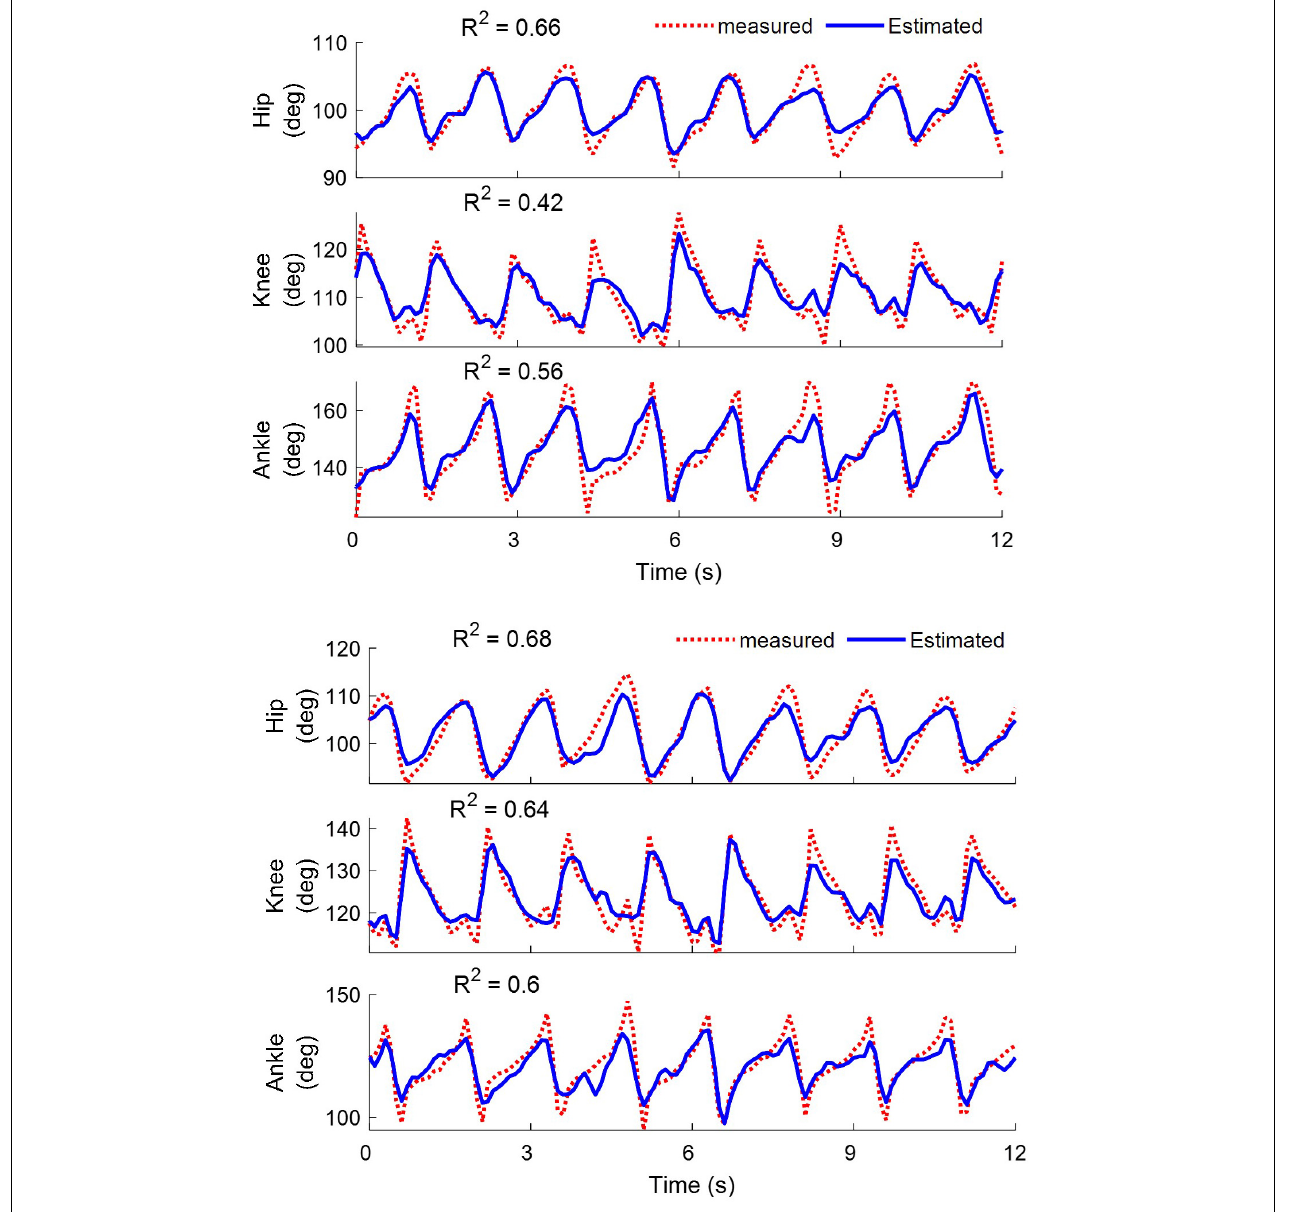
FIGURE 11 | Examples of decoding the hip, knee, and ankle joint angles for the left (top) and right leg (bottom) during walking on the treadmill. The results are obtained from cat 1 on day 12 after implantation. The coefficient of determination ( R 2 ) values obtained for the left leg are 0.66, 0.42, and 0.56 for the hip, knee and ankle angles, respectively. For the right leg, the R 2 values are 0.68, 0.64, and 0.6 for the hip, knee, and ankle angles,